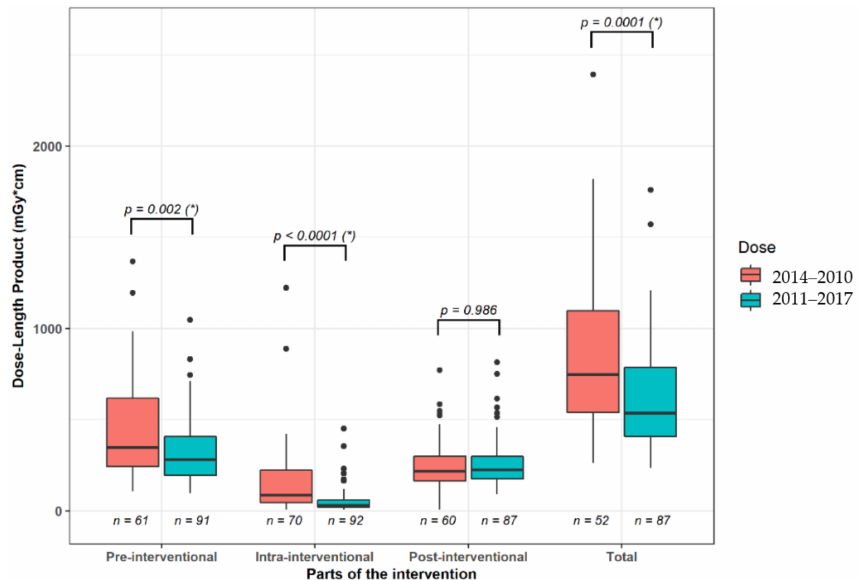
Figure 4. Boxplots of the median radiation dose between the time intervals of the years 2004–2010 and years 2011–2017 for parts of the interventional CT scan and for the whole procedure. (*) indicate significant group differences.